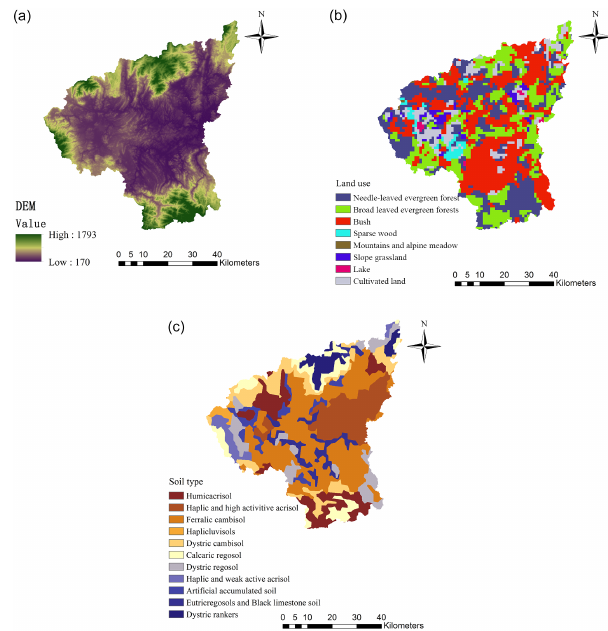
Figure 3. Terrain property data of UMWC: (a) DEM, (b) land use type and (c) soil